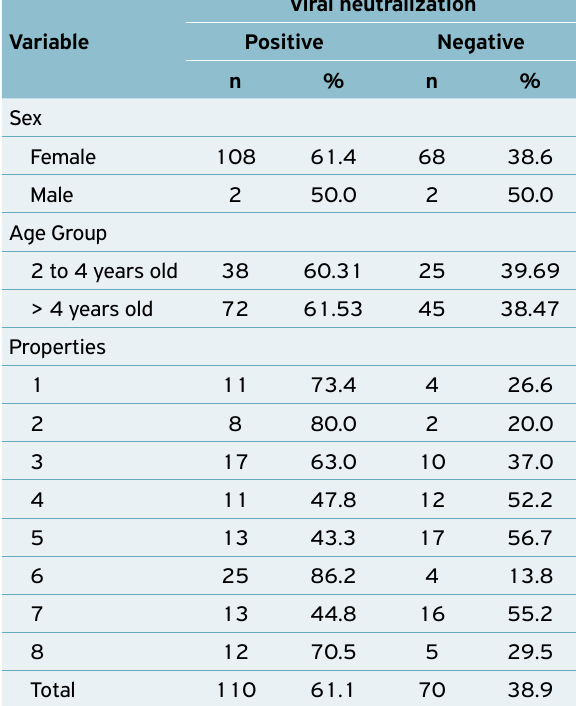
Table 1. Prevalence of bovine alphaherpesvirus type 1 infection by sex, age group and dairy properties in the municipality of Senador Guiomard, Acre,